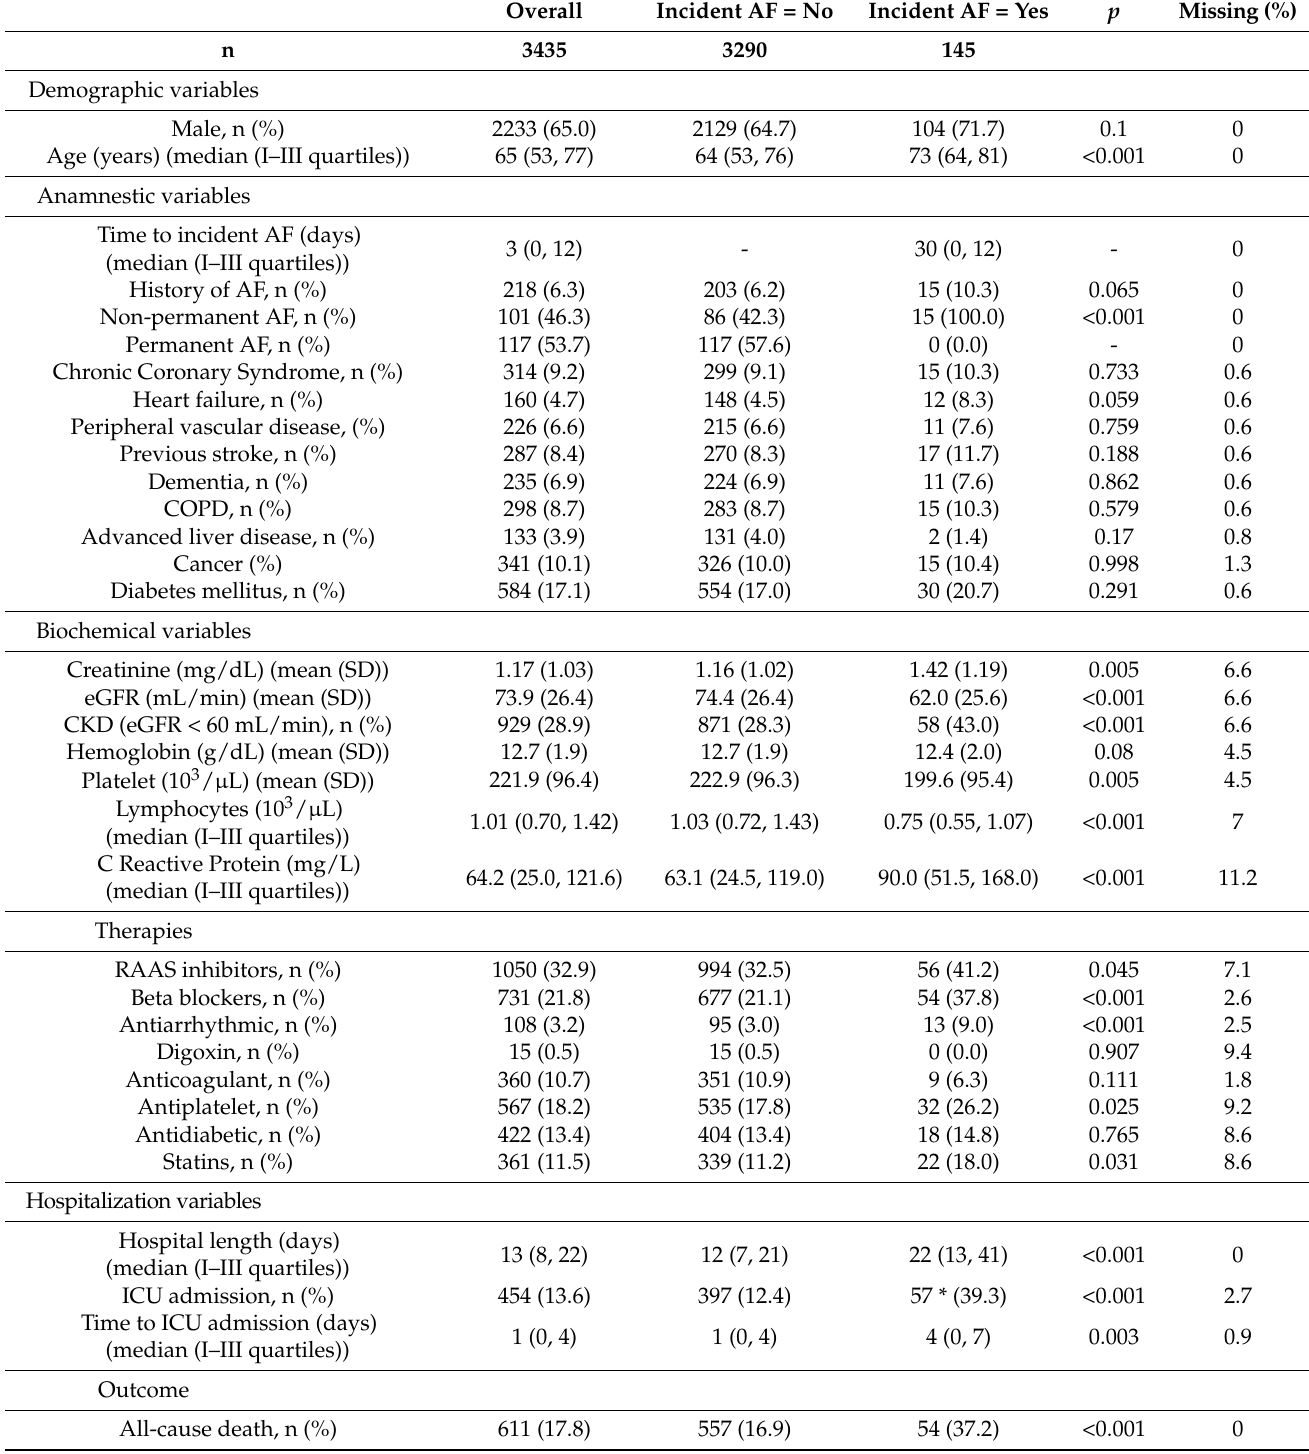
Table 1. Clinical characteristics of the included patients, overall and divided according to in-hospital incident AF